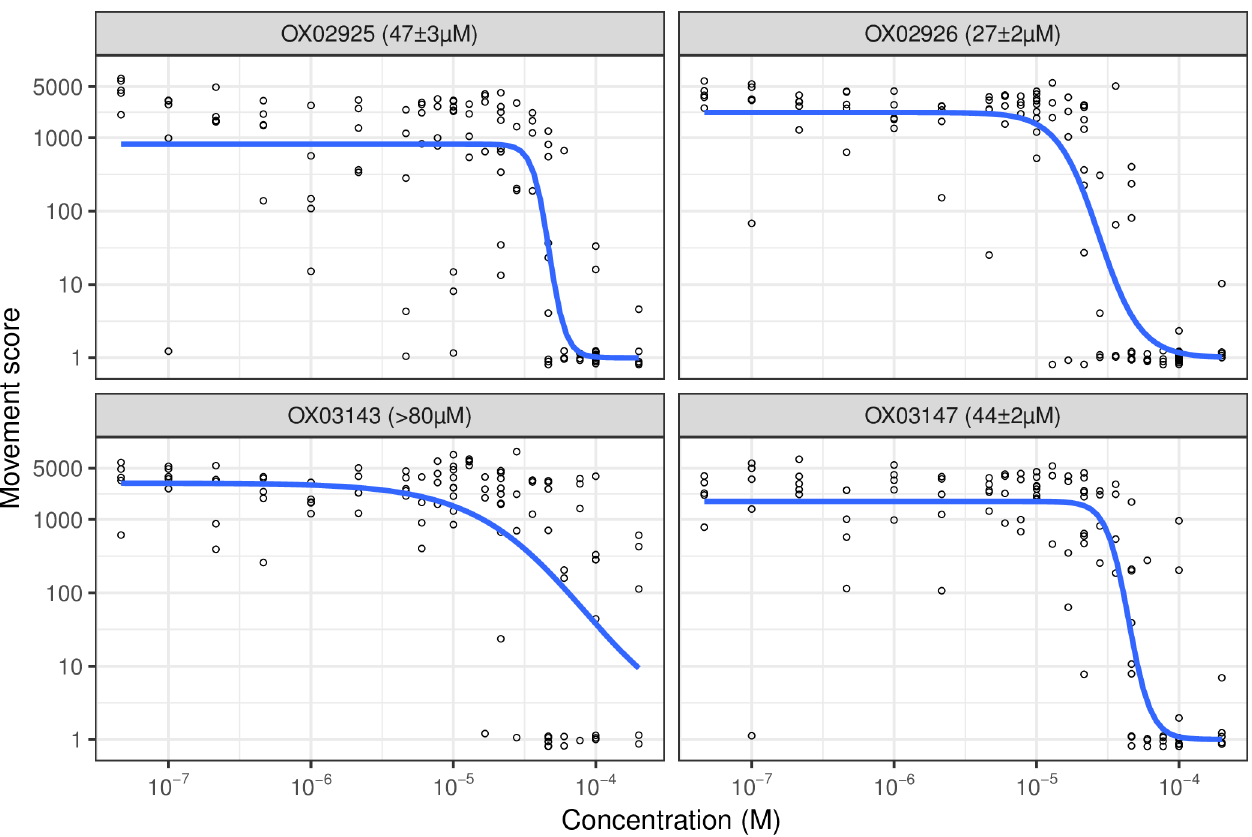
Fig 3. Concentration-response curves for resynthesized DATPs in the T . murisex vivo adult motility assay. n = 4 or 5 wells per concentration per compound, each replicate on a different 96-well plate using worms from different mice. Blue line indicates concentration-response curve fitted with the 3-factor log-logistic model using drc [16]. Figure in parenthesis indicates EC 50 estimate ± standard error from this model. OX03143 did not clearly form a sigmoidal curve in the range of concentrations used in this assay so we report the EC50 estimate as > 80 μ